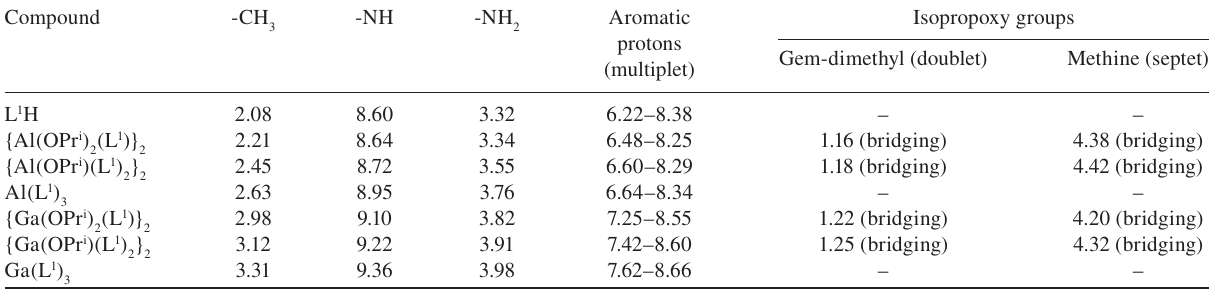
Table 1 1 H NMR spectral data ( δ ppm) of L 1 H and its aluminum(III) and gallium(III) complexes.